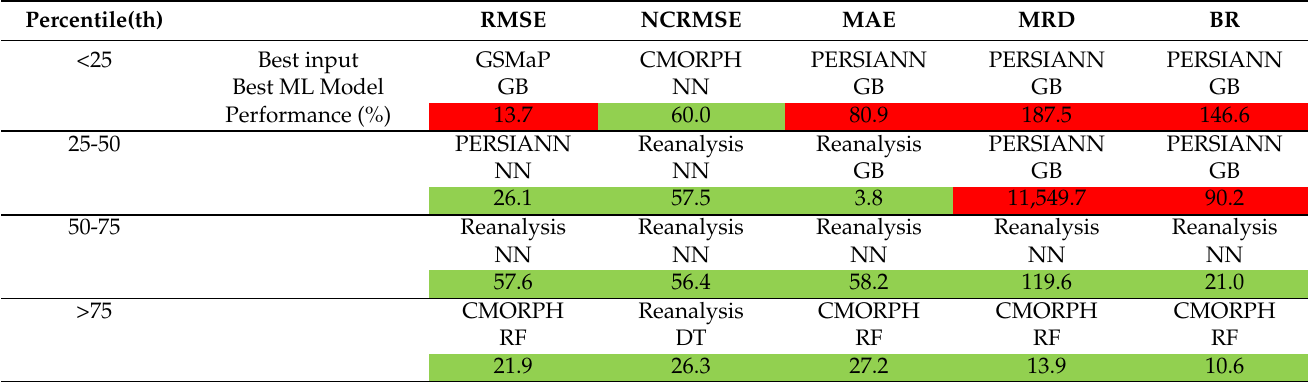
Table 4. Best input and ML model based on different metrics in different percentile ranges. Red indicates a worse performance than the input models and green indicate a better